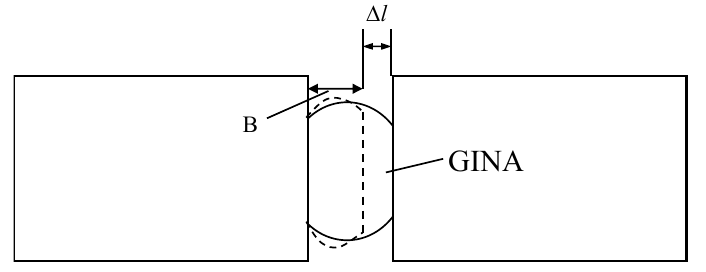
Figure 11. Geometric diagram of expansion